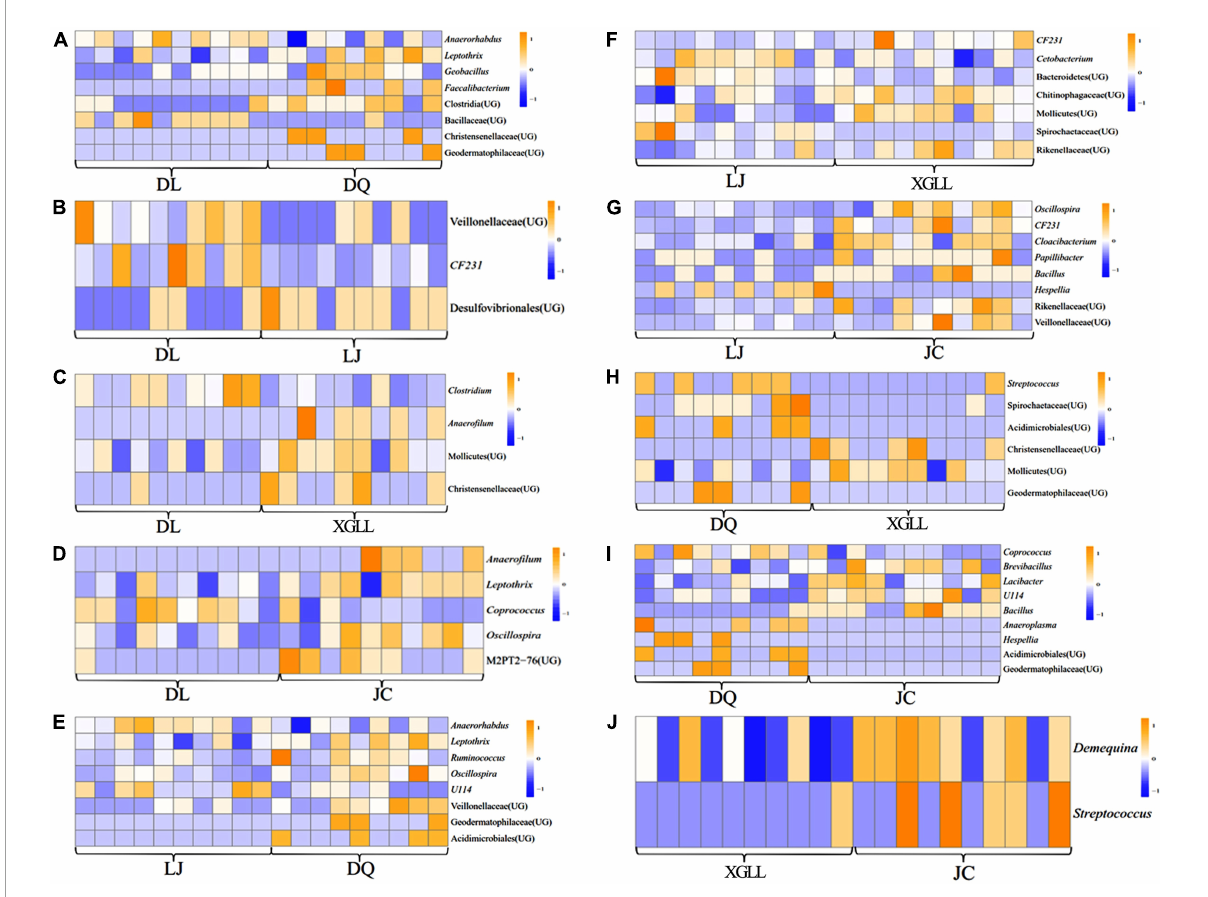
FIGURE6 Differential microbial analyses of feces in Eothenomys miletus between the two regions. (A) DL vs. DQ; (B) Dl vs. LJ; (C) DL vs. XL; (D) DL vs. JC; (E) LJ vs. DQ; (F) LJ vs. XL; (G) LJ vs. JC; (H) DQ vs. XL; (I) DQ vs. JC; (J) XL vs.